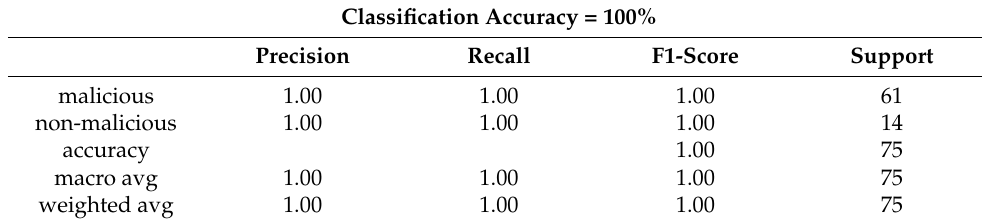
Figure A7. Extra Trees classifier model summary with a confusion matrix. Table A7. Gaussian NB classifier.